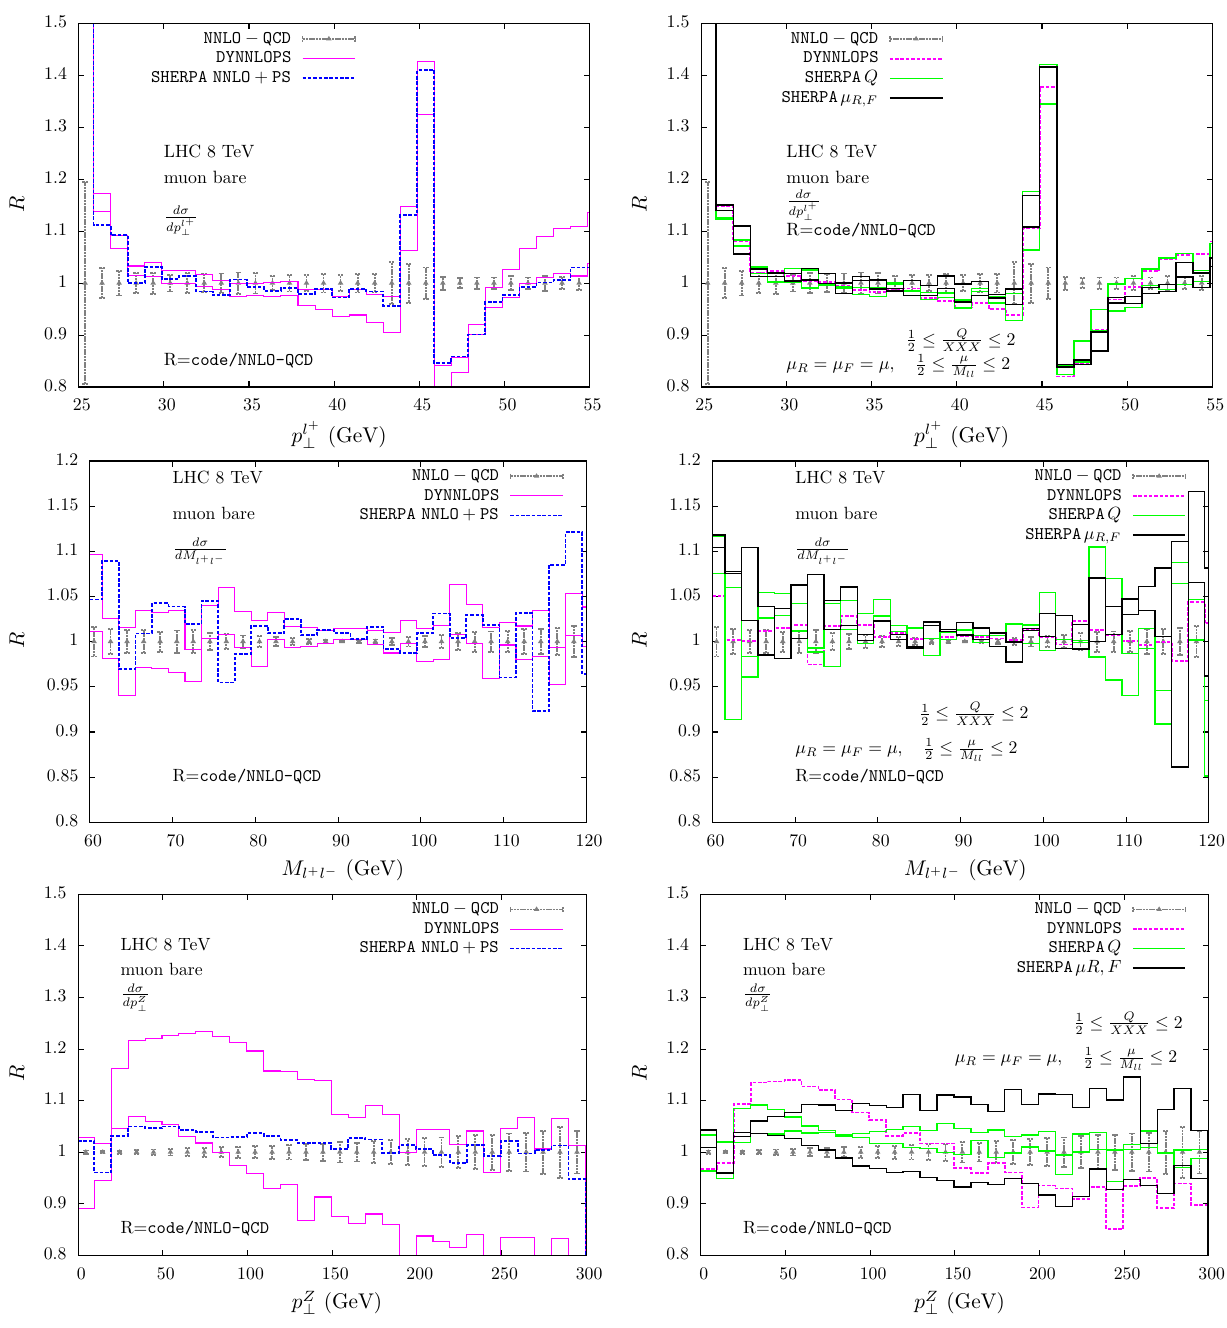
Fig. 23 Higher-order QCD effects, expressed in units of NNLO QCD, due to the matching of resummed and fixed order results, in codes with NNLO accuracy, for the process pp → μ + μ − + X , obtained with ATLAS/CMS cuts at the 8 TeV LHC. The SHERPA NNLO+PS uncertainty bands for renormaliza- tion/factorization scales ( black ) and shower scale ( green ) variations are shown in the right plots . The DYNNLOPS ( pink ) uncertainty bands are